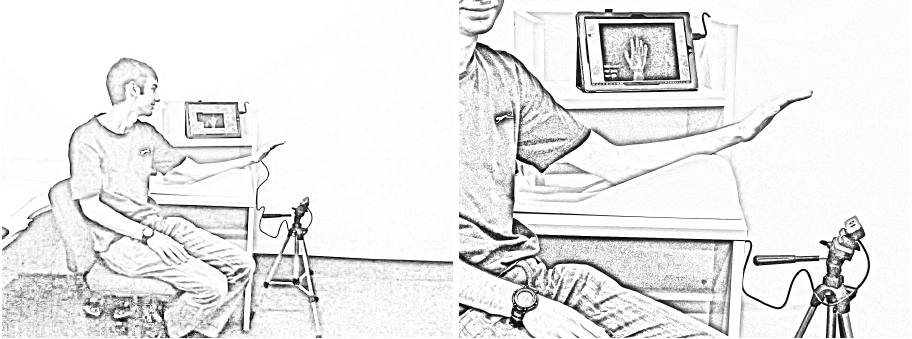
Figure 7. The left hand of the man was measured by our